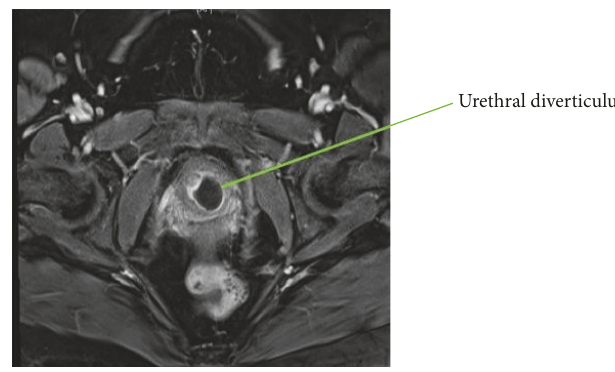
Figure 1: Pelvic MRI, axial view of urethral diverticulum.